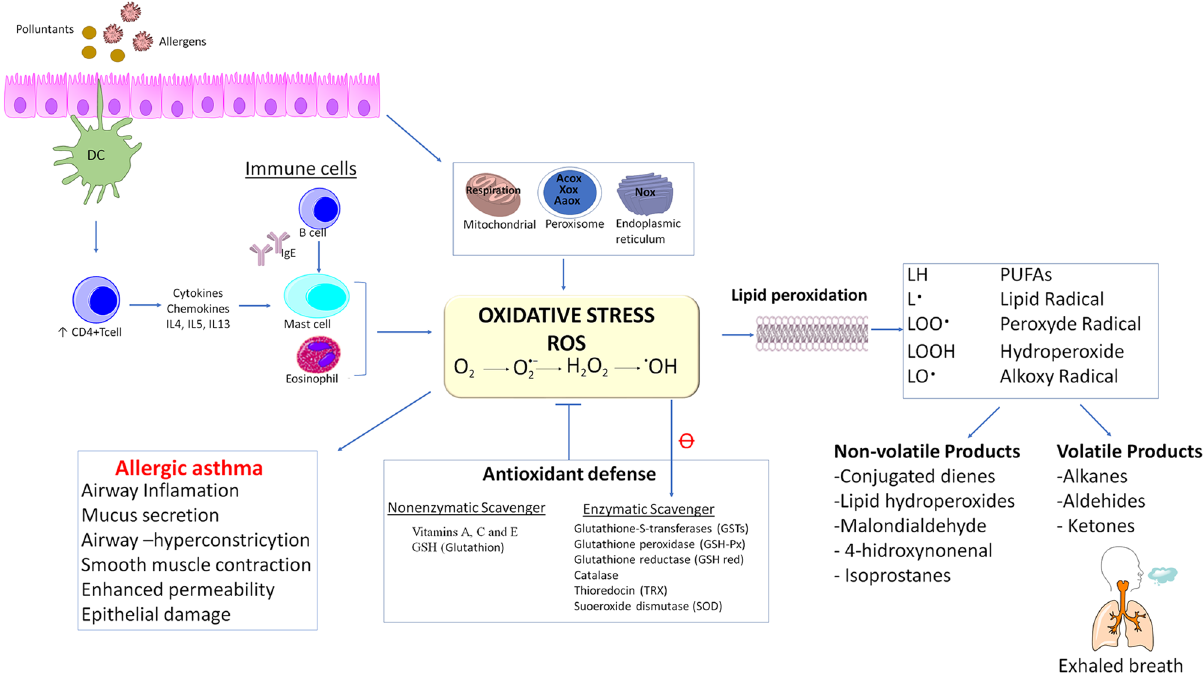
Figure 1. Lipid peroxidation and volatile organic compounds production in allergic asthma. PUFAs polyunsaturated fatty acids, ROS reactive oxygen species, Nos NADPH oxidase, Acox AcilCoA-oxidase, AaOx amino acid